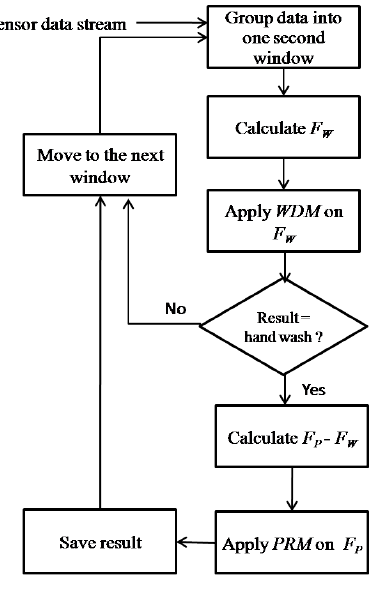
Figure 7: Runtime classification